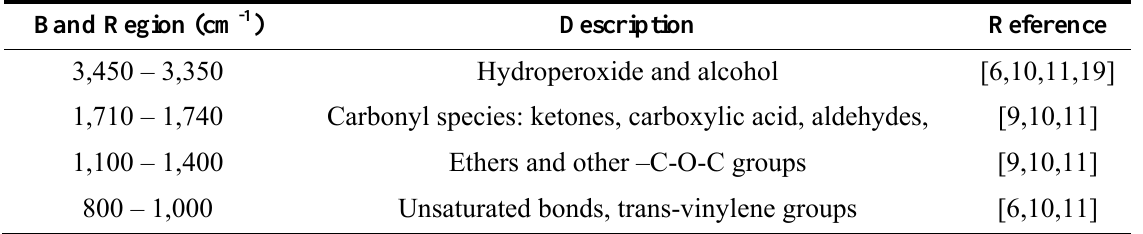
Table 1. Major FTIR bands associated with UHMWPE and its oxidized